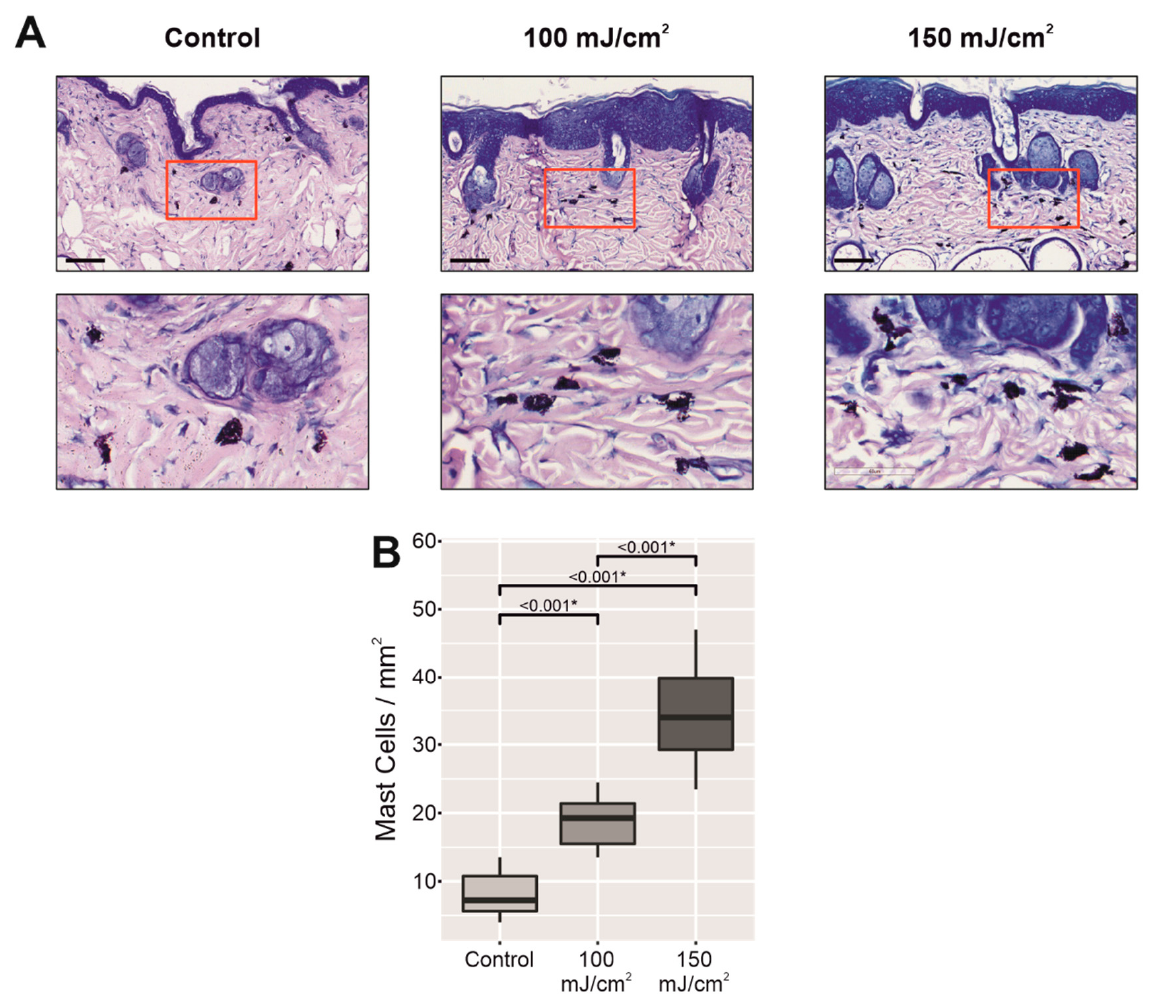
Figure A2. Giemsa staining to detect mast cell infiltrates in the dermis. In the bottom line, there is a zoomed-in view of the mast cells with their cytoplasm containing metachromatic granules composed of heparin and histamine. The scale bar represents 100 µm ( A ). Below, we give the quantities of mast cells in the UV-B-irradiated groups, 100 and 150 mJ/cm 2 , with respect to the nonirradiated group ( B ). Data are expressed as means ± SD of at least 10 measurements of a number of mast cells in histological samples of skin with CFC in each group with UV-B irradiated skin with respect to the nonirradiated group. * p -values are indicated in the figure and marked with an asterisk when significant, p < 0.05 (Kruskal–Wallis test with Scheffe post hoc test).